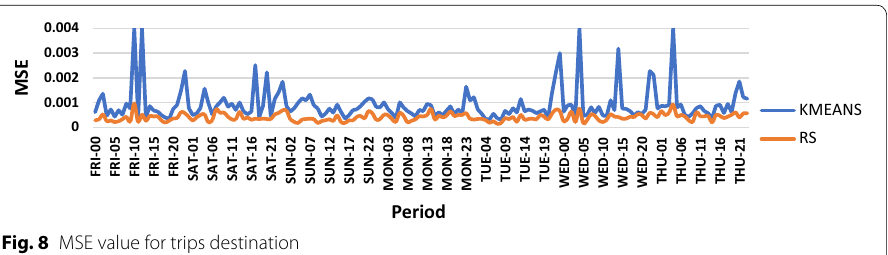
Fig. 8 MSE value for trips